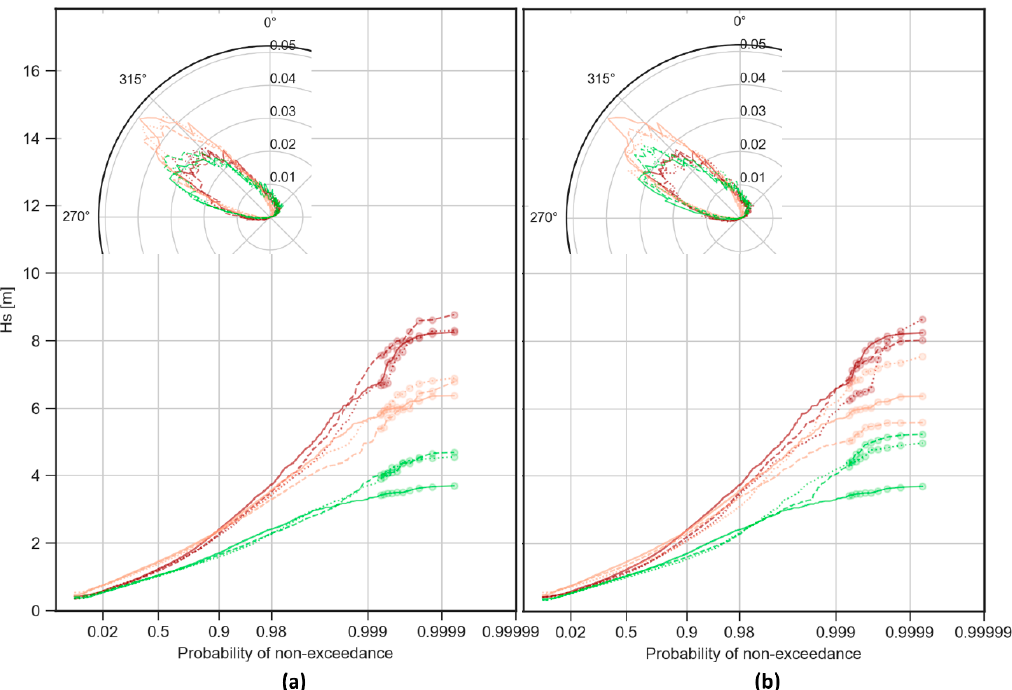
Figure A2. CDFs of the propagated values of H S at deep waters (summer dataset) with a detail of the polar PDFs of wave directions for: ( a ) Control simulations and short-term simulations (2026–2045) of all models and concentration scenarios; ( b ) Control simulations and long-term simulations (2081–2100) of all models and concentration scenarios.